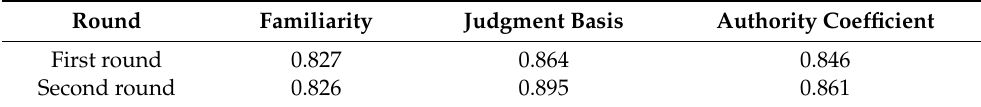
Table 1. Expert authority